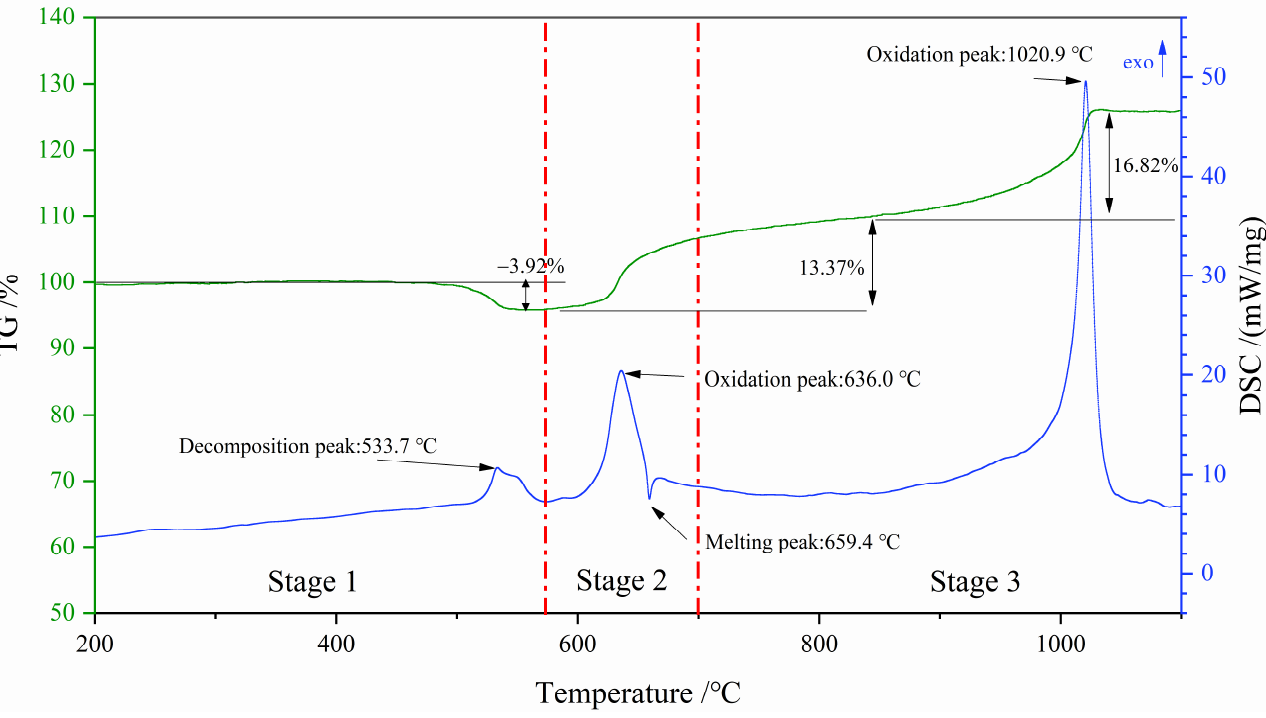
Figure 10. The TG-DSC results of the micro-nano composite aluminum powder in an air atmosphere at 20 °C/min.